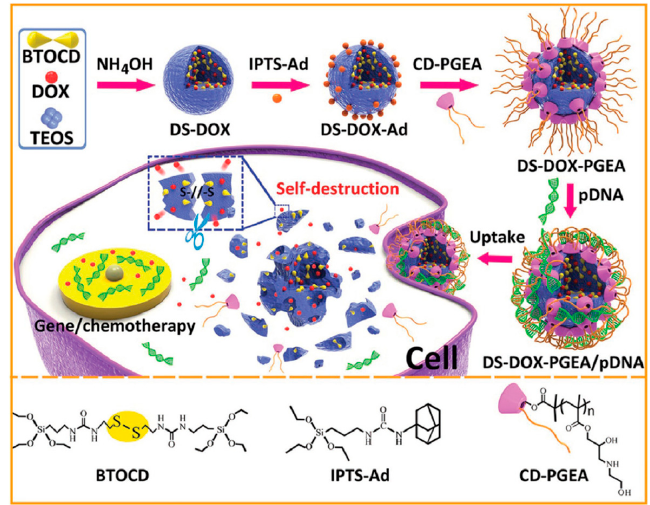
Figure 11. Schematic representation of disulfide-bridged silica NPs for dual doxorubicin and p53 gene delivery. Doxorubicin is loaded in situ during the synthesis of the NPs, which are further modified with a polycation for gene condensation. Upon internalization, the NPs are destroyed by GSH, delivering the drug and the gene. Adapted with permission from [66]. Copyright Wiley, 2017.